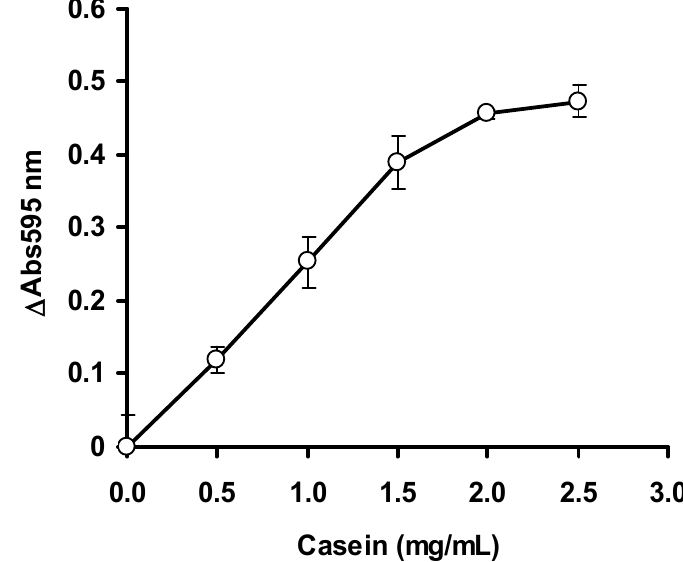
Figure 3 . The effect of casein concentration on the ficin dye-binding assay. Error bars represent mean ± standard deviation ( n = 3).